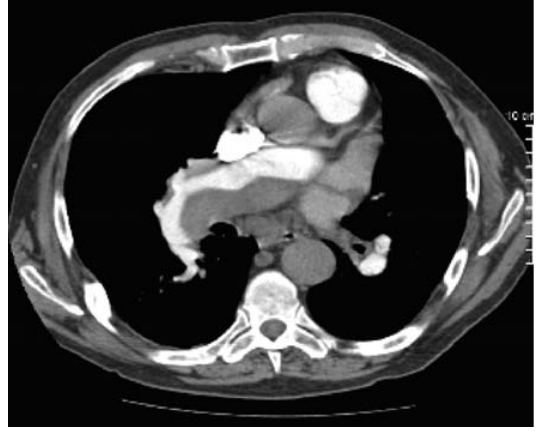
Contrast-enhanced helical CT demonstrating widespread centrally located chronic pulmonary thromboemboli (arrow) and ensuing obstruction in the diameter of the arterial lumen when compared to the external diameter of the pul- monary artery, in a patient with a severe form of proximal and distal chronic thromboembolic pulmonary hypertension (same patient as in figure